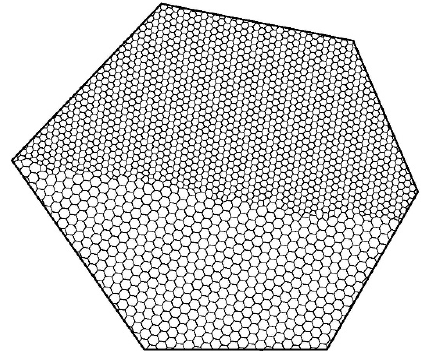
Figure 3. A picture of a 2D wet foam with low angle grain boundaries.